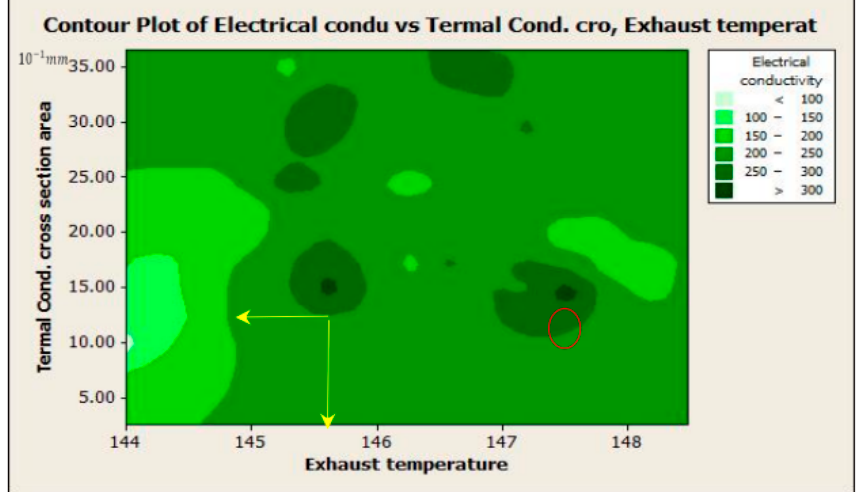
Figure 13. The exhaust gasket thickness affects the electrical conductivity at the highest available level. “Hint: the red circle points to the preferred significant parameters values selection”.